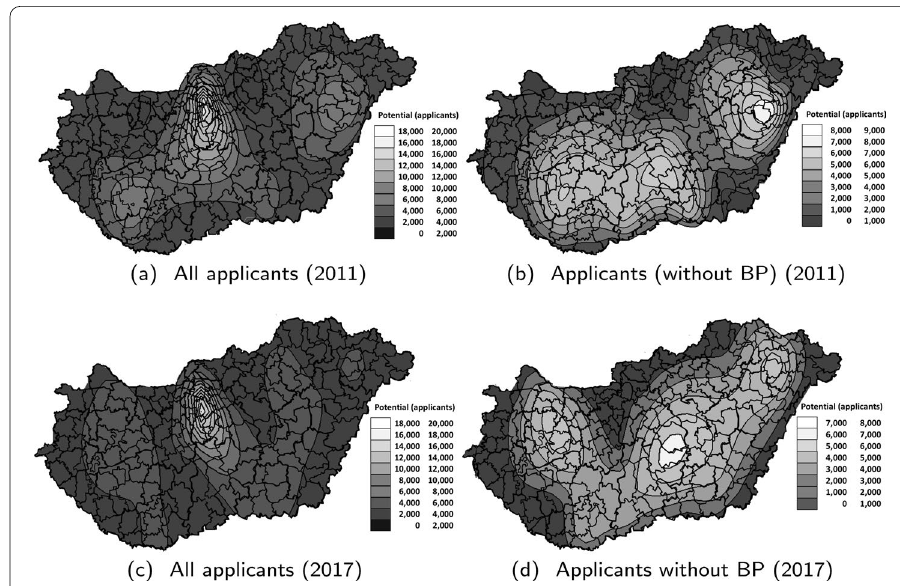
Fig. 7 Results of the gravity‑based potential models (2011, 2017). BP: Budapest, the capital of Hungary